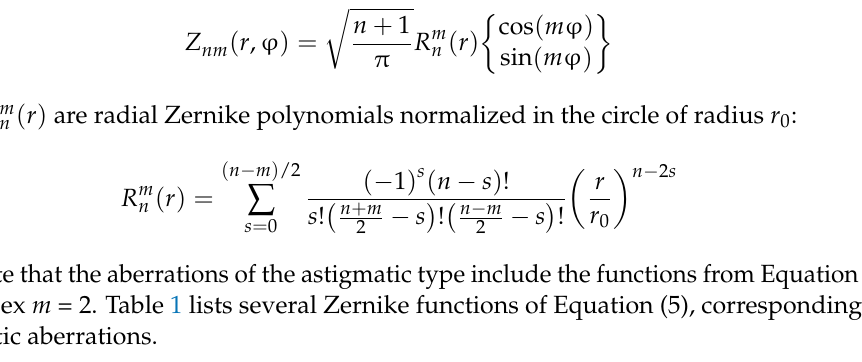
Table 1. Zernike functions of Equation (5) corresponding to astigmatic aberrations. Aberration Type n m